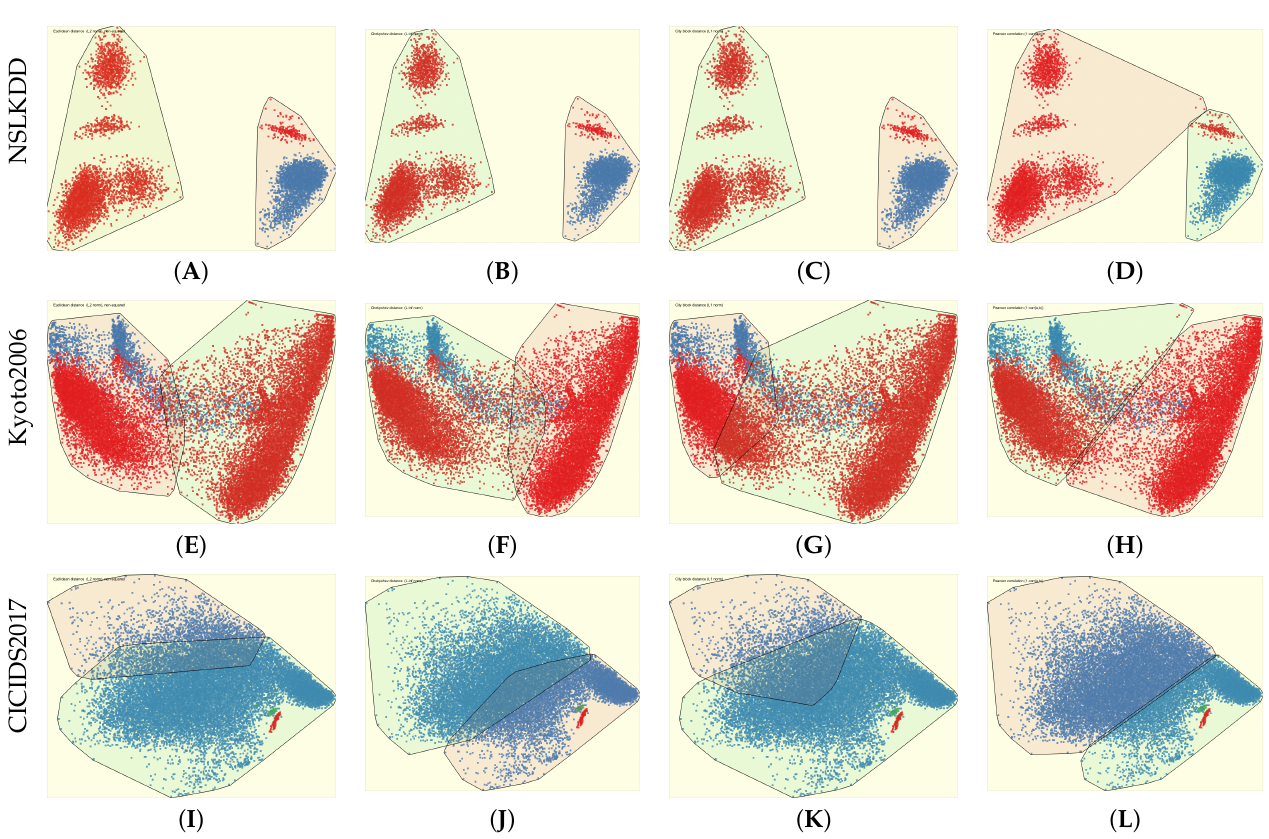
Figure 7. Visualizations of the analyzed k = 2 clusters with different distance metrics (Euclidean ∞ distance (L 2 ), Chebyshev distance (L ), City-block distance (L 1 ), and Pearson correlation coefficient (R 2 )) on the PCA features within visualizations using an Agglomeration hierarchical clustering technique. The determined clusters are represented as solid connected lines. ( A ) Clustering result for ∞ the NSLKDD dataset with L 2 ; ( B ) Clustering result for the NSLKDD dataset with L ; ( C ) Clustering result for the NSLKDD dataset with L 1 ; ( D ) Clustering result for the NSLKDD dataset with R 2 ; ( E ) Clustering result for the Kyoto2006 dataset with L 2 ; ( F ) Clustering result for the Kyoto2006 ∞ dataset with L ; ( G ) Clustering result for the Kyoto2006 dataset with L 1 ; ( H ) Clustering result for the Kyoto2006 dataset with R 2 ; ( I ) Clustering result for the CICIDS2017 dataset with L 2 ; ( J ) Clustering ∞ result for the CICIDS2017 dataset with L ; ( K ) Clustering result for the CICIDS2017 dataset with L 1 ; ( L ) Clustering result for the CICIDS2017 dataset with R 2